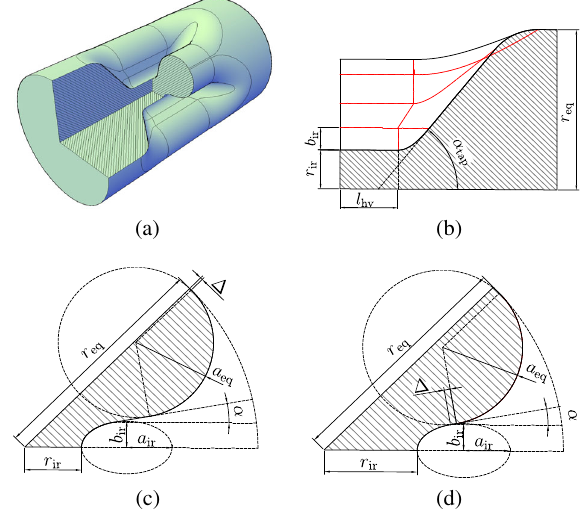
FIG. 11. Four-vane cavity design. (a) 3D view of the cavity with an open-left segment to depict the unique parts of the longitudinal and transverse cross-section. A quarter of the longitudinal cross section is shown in (b) while (c) and (d) show two different versions of the transverse cross section (only an eighth). The difference is given by a displacement of the circle resulting from a larger iris radius r in (d). The beam is located ir along the bottom line in (b) or at the lower left corner in (c) and (d), respectively.